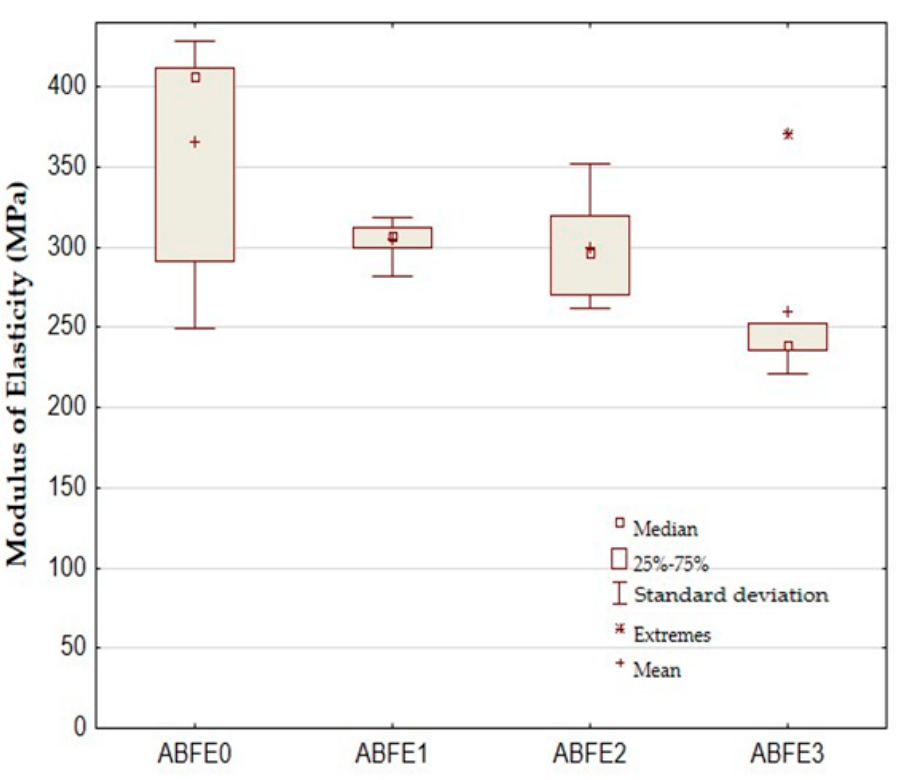
Figure 6. Static tensile test of adhesive bonds—modulus of